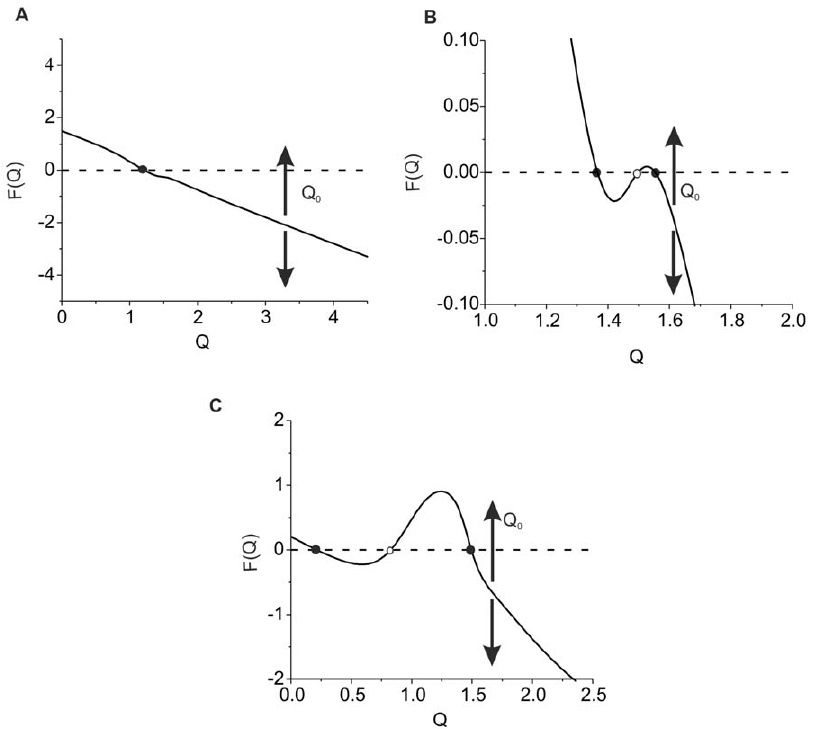
Figure 12. Interplay of the two regulation mechanisms balancing average activity. Steady state activity levels are defined by zeros of function F(Q) . Parameter values: z 0 =p 0 =0, z 1 =p 1 =1, h z =1, k z =0.15, h p =1.5, k p =0.05, k q =0.01, a q =0.0001 msec 2 1 , b q =0.01 msec 2 1 , a z =0.001 msec 2 1 , b z =0.01 msec 2 1 , a p =0.001 msec 2 1 , b p =0.01 msec 2 1 , c p =0.1, I 0 =4.5 m A/cm 2 , b 0 =6, k I =0.6625, and k b =0.4762. A. Monotonic regulation for rather low feedback gains, c Z =0.03, c ZR =0.01, Q 0 =1.5 . B. Bistability for high input frequency, c Z =0.04, c ZR =0.01, and Q 0 =1.95 . C. Bistability for low input frequency, c Z =0.1, c ZR =0.1, and Q 0 =0.2 .